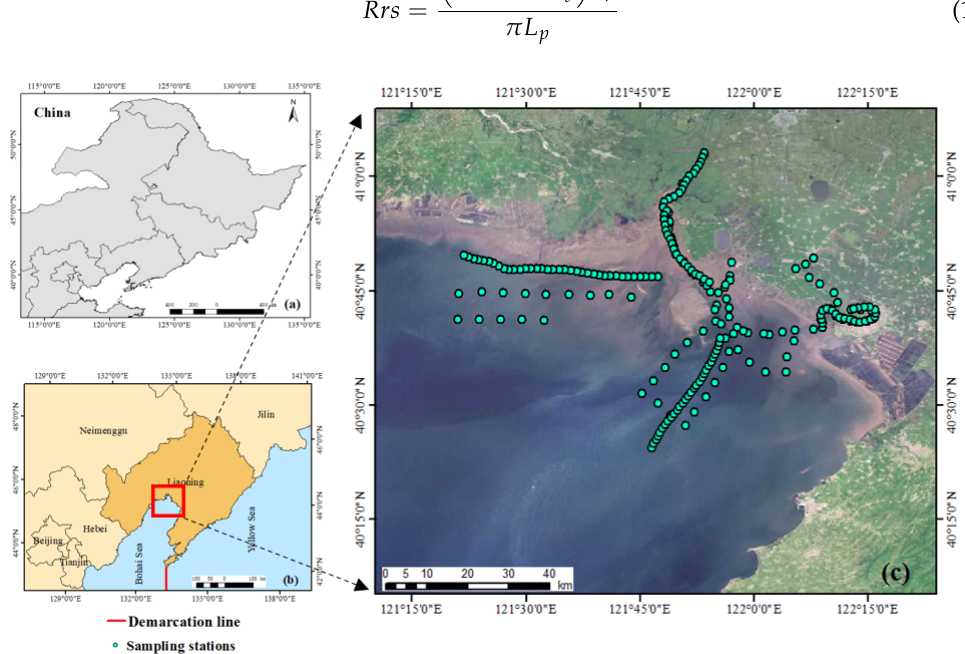
Figure 1. ( a – c ) Location of the study area and spatial distribution of sampling stations.